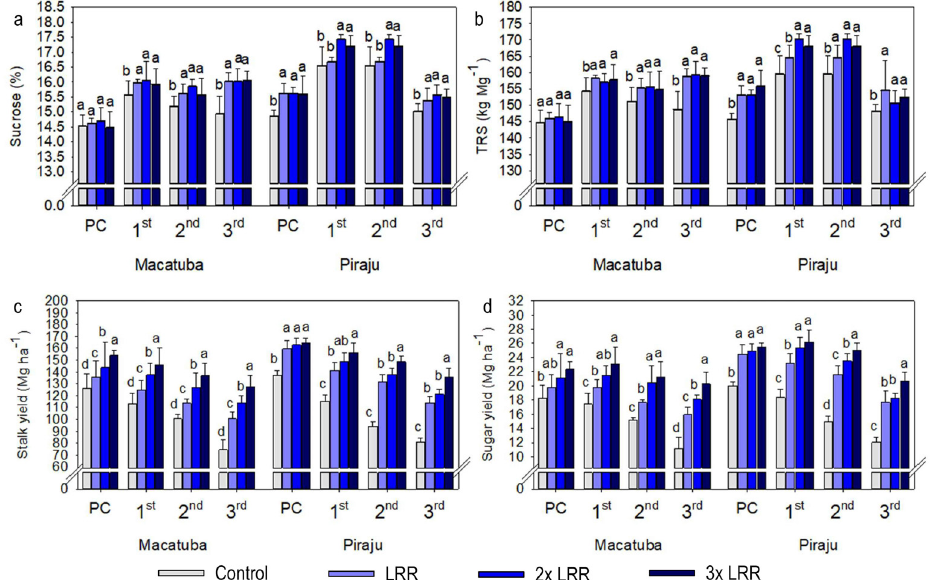
Figure 5. Sucrose ( a ), total recoverable sugar (TRS, b ), and yields of stalks ( c ) and sugar ( d ) under increasing lime rates at Macatuba and Piraju under deep strip-tillage (DT) in plant cane and first, second, and third ratoons. Different lowercase letters indicate significant differences between lime rates for each growing season (LSD, p ≤ 0.1). The error bars express the standard error of the mean ( n = 4). The agronomic efficiency index (AEI) was calculated to evaluate the efficiency of 2 × and 3 × LRR compared with LRR. In all cases, the AEI values of 2 × and 3 × LRR were above 100%, confirming the greater efficiency of higher-than-recommended lime rates compared with LRR. Under CT and DT, across the complete sugarcane cycle (summing the